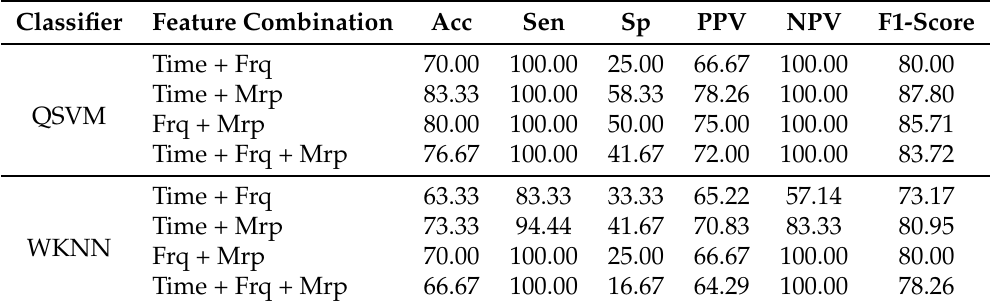
Table 6. Performance evaluation with combinations of time, frequency (Frq), and morphological (Mrp) features using different classifiers for Experiment 2 (no pain vs. low pain). (QSVM: Quadratic- SVM, WKNN: Weighted-KNN, AB: AdaBoost, BLNN: bi-layered neural network, TLNN: tri-layered neural network). Bold text indicates the best